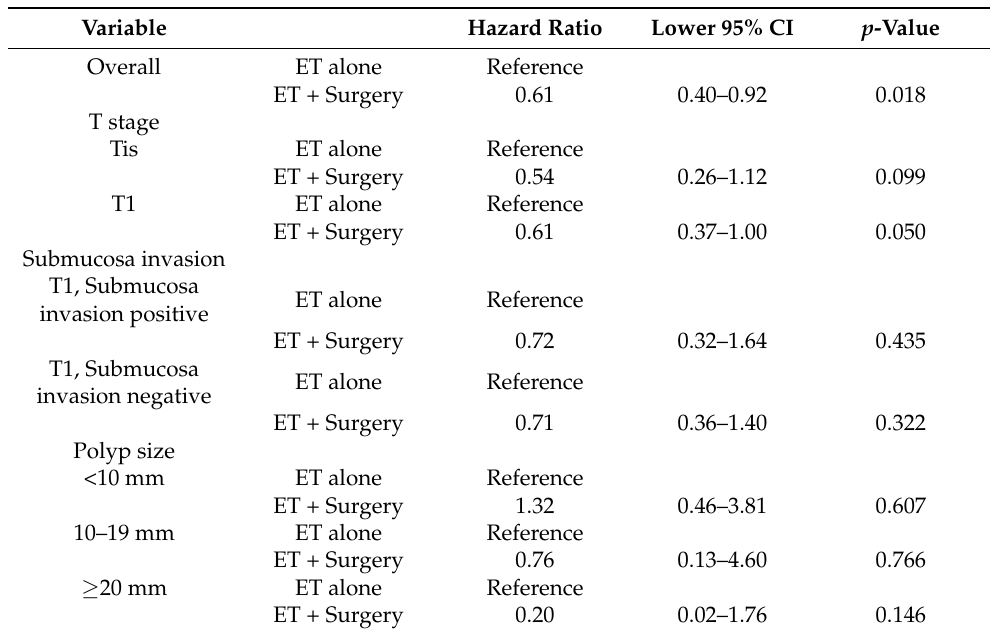
Table 3. Univariate Cox regression